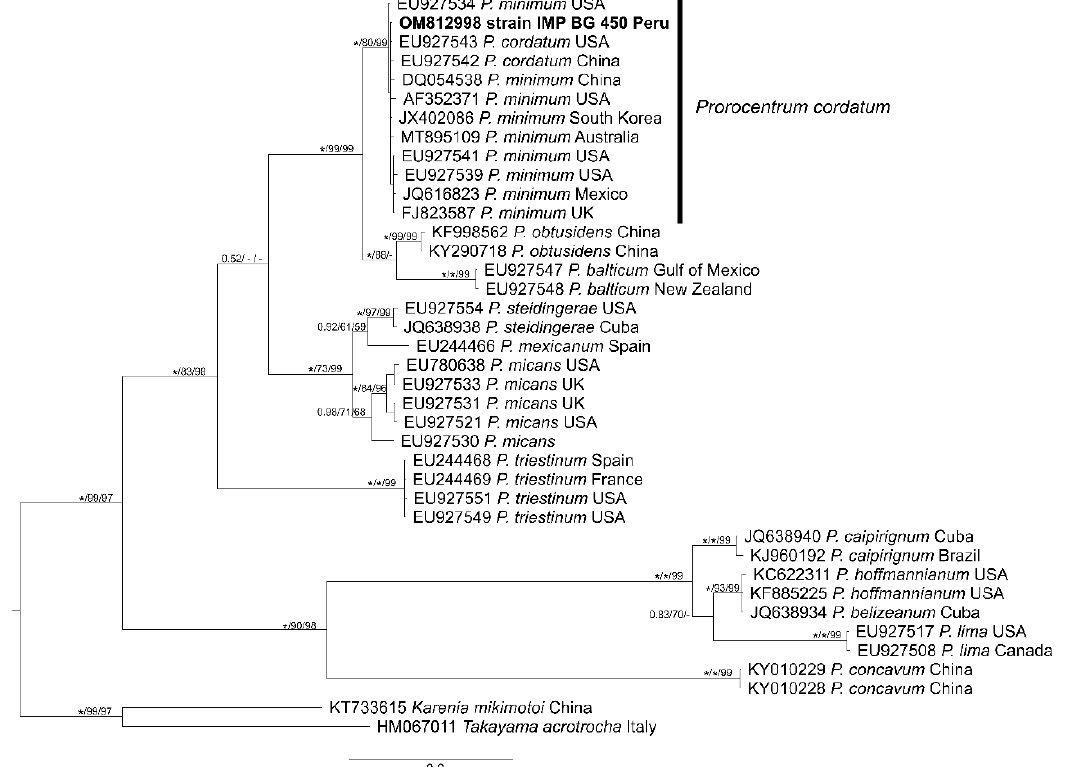
Figure 7. Prorocentrum Bayesian tree based on ITS sequences. The numbers above lines are nodal supports that indicate Bayesian posterior probabilities (PP), and bootstrap support values from ML and NJ. * Indicates total support values. “ - ” Indicates that phylogeny structure for ML or NJ analyses are different at the node. The sequence obtained in this study is indicated in bold.